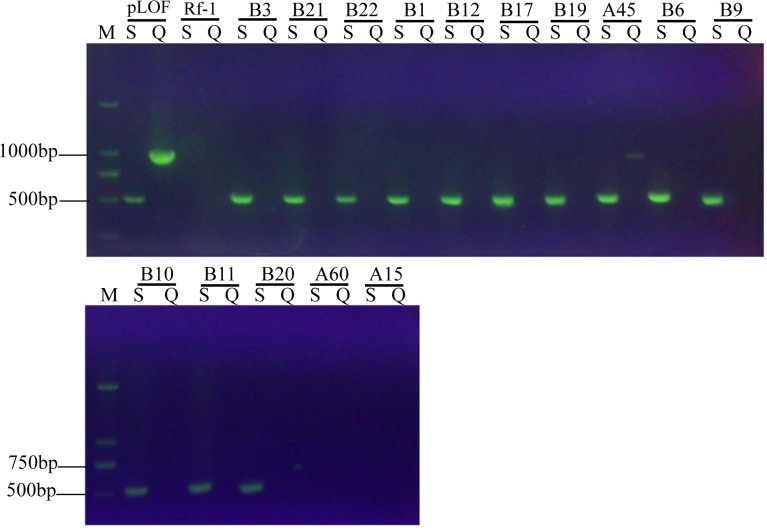
PCR detection of insertion of mini-Tn10 together with kanamycin resistance marker (IS-km-IS region) in LAAO-altered mutants.S: PCR using primers Tn10KAP3 and S1; Q: PCR using primers DTn10AP3 and Q2; pLOF: PCR using plasmid pLOF/Km as template (positive control); Rf-1: PCR using genomic DNA of wild type strain Rf-1 as template (negative control); B3, B21, B1, B12, B19, A45, B6, B9, B10, B11, B20, A60 and A15: PCR reaction using genomic DNA from the corresponding mutant as template.